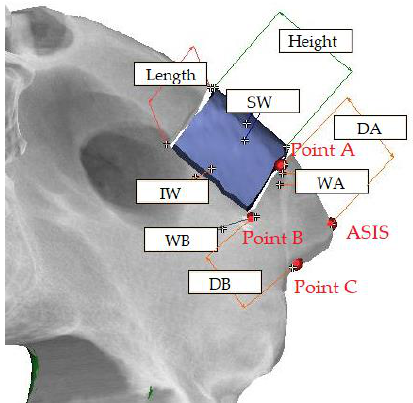
Figure 2. Reference points and the distance between reference points of a non-fracture patient. Point A was defined as the contact point by drawing a vertical line on the boundary of the harvested bone segment from the ASIS. Point B was defined as the contact point by drawing a vertical line on the boundary of the harvested bone segment from point C. Point C was defined as the most concave point between the ASIS and anterior inferior iliac spine. (DA: distance between the ASIS and Point A; DB: distance between Point B and C; WA: width at point A; WB: width at point B; SW: midpoint width on the superior part of harvested bone; IW: midpoint width on the inferior part of harvested bone).